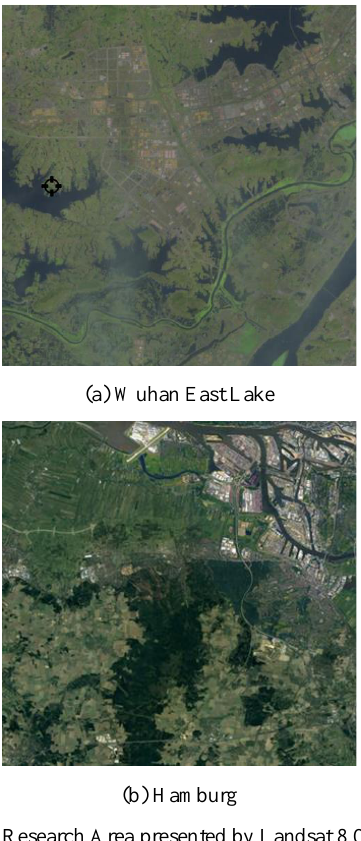
Figure 1. Research Area presented by Landsat 8 OLI RGB Region